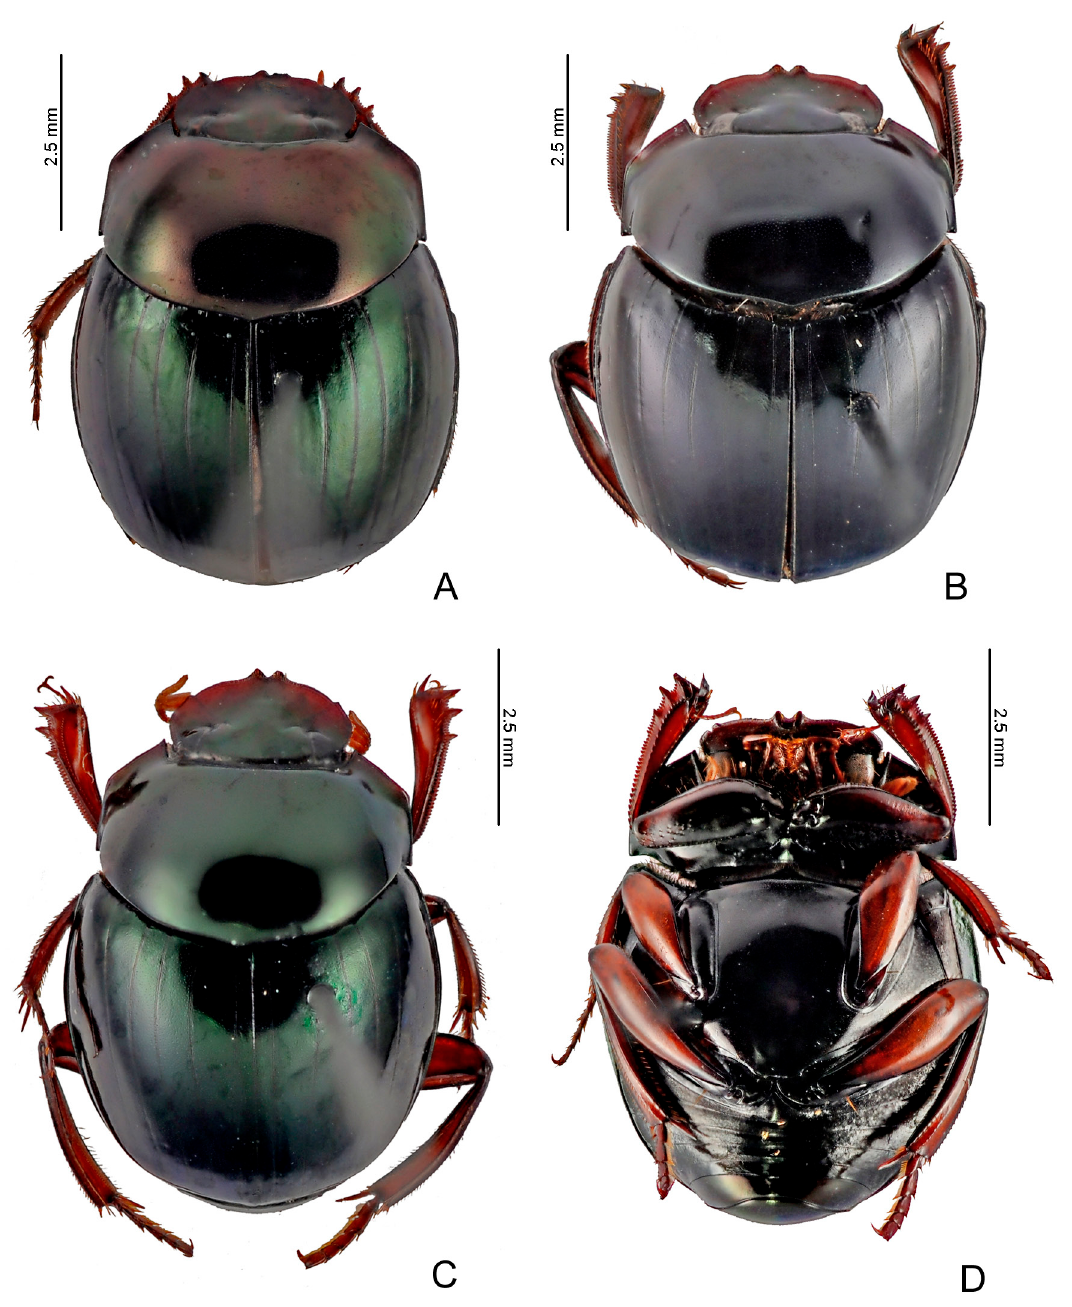
Fig. 37. Sylvicanthon seag sp. nov. A . Dorsal view of a bicolour specimen (present only on the banks of the Amazon River and in the Brazilian state of Maranhão). B . Dorsal view of a bluish specimen. C . Dorsal view of a greenish specimen. D . Ventral view of a greenish